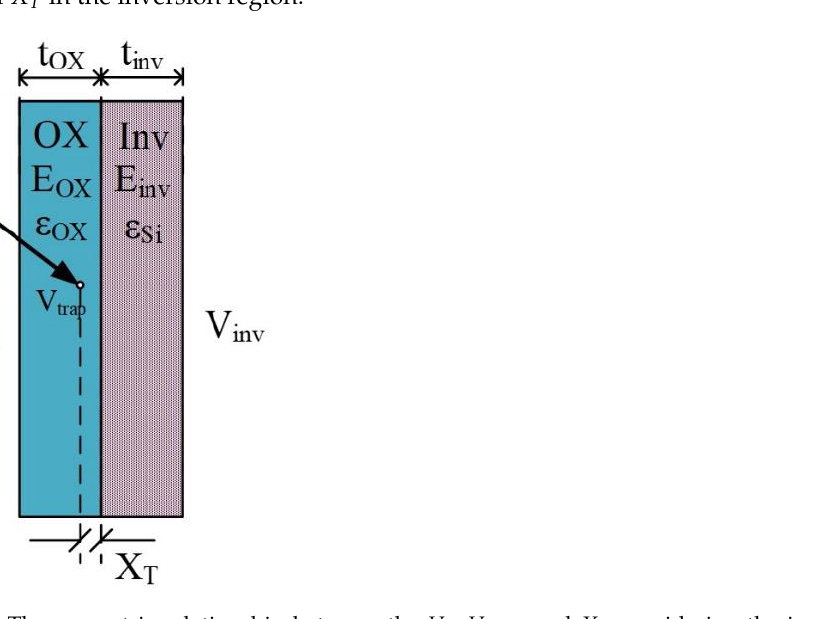
Figure 9. The geometric relationship between the V g , V Trap , and X T considering the inversion layer thickness.